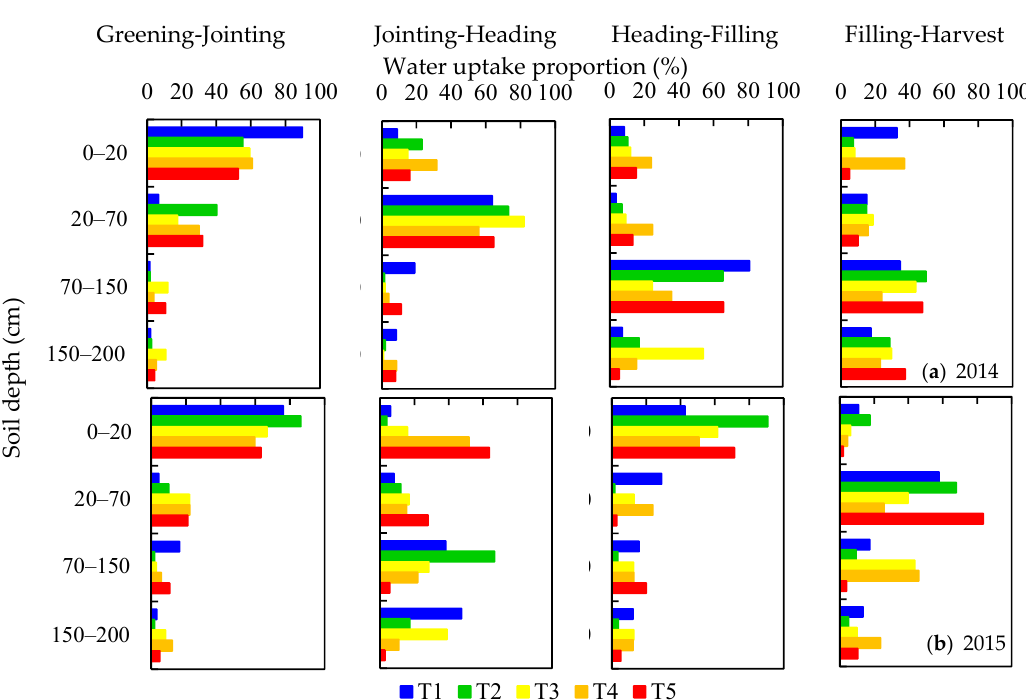
Figure 7. Distributions of water uptake proportions for winter wheat under different treatments at each growth stage in the ( a ) 2014 and ( b ) 2015 seasons.